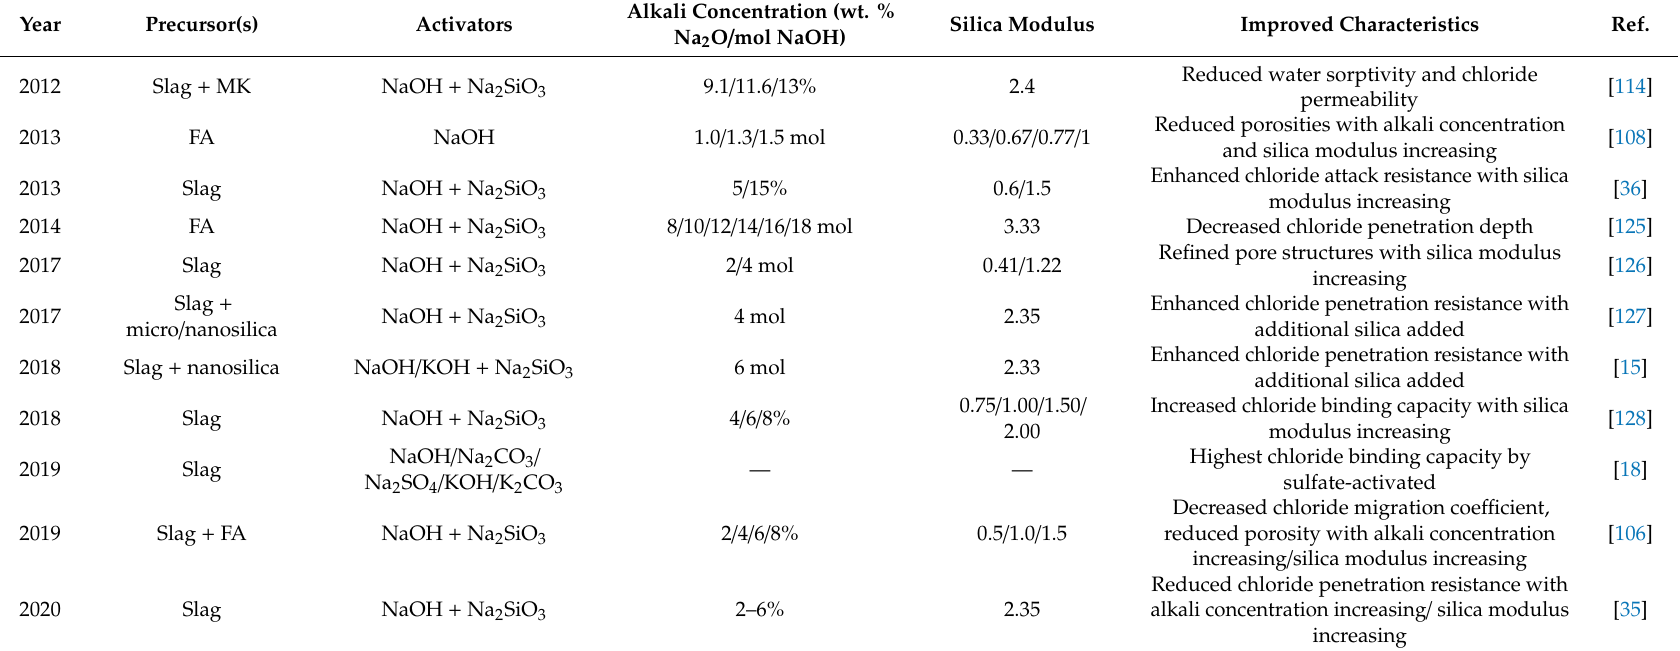
Table 4. Activator compositions and silica moduli a ff ecting the chloride resistance of